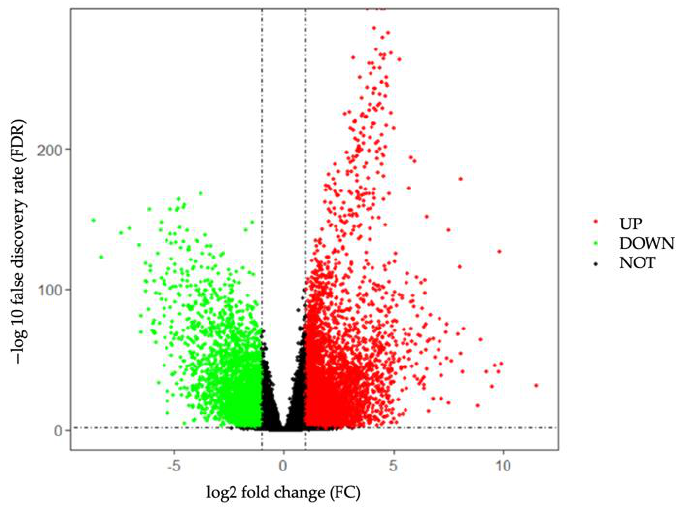
Figure 2. Volcano plot of DEGs between 116 TNBC and 113 normal tissue samples.